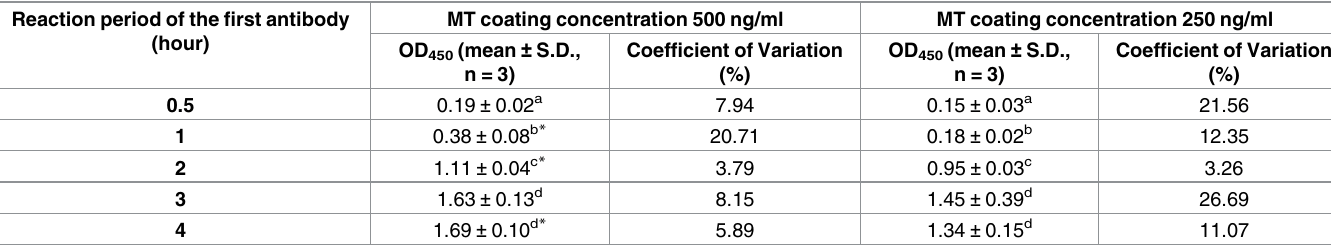
Values within a column having different superscript letters are significantly different and values within a line with “ * ” are significantly different ( p < 0.05). N means sample number.